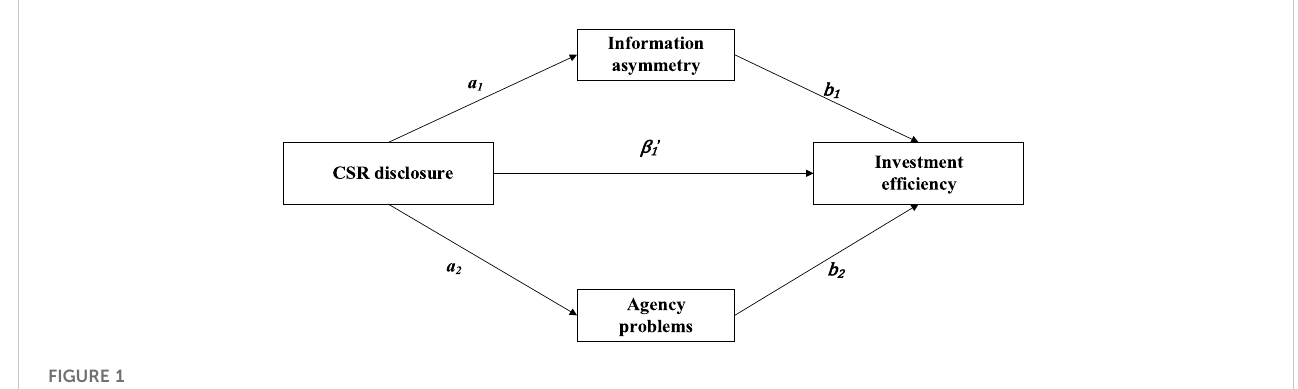
FIGURE 1 Model diagram of the multiple mediation